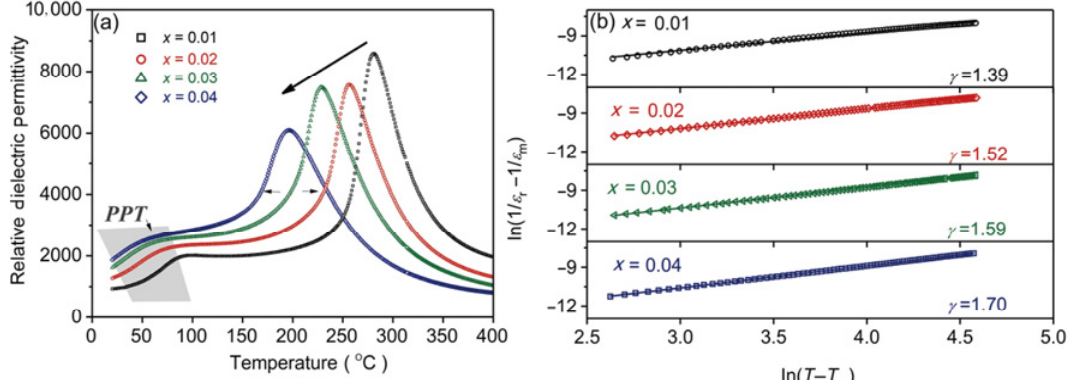
Fig. 3 (a) Relative dielectric constant as a function of the temperature of LKNNS  EuNZ  x BZ ceramic samples at 1 kHz; (b) plots of ln(1/ ε r − 1/ ε m ) vs. ln( T − T m ) for LKNNS  EuNZ  x BZ